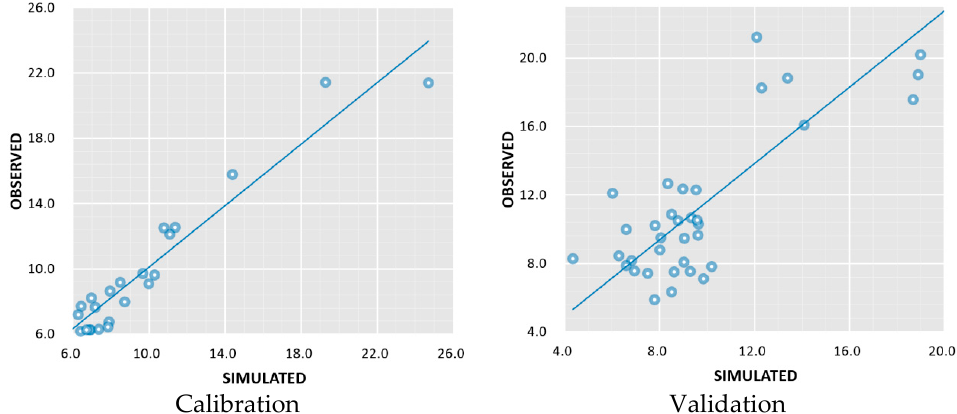
Figure 6. Deterministic coefficients of the monthly observed and simulated runoff of the Hot Spring station. Table 4. The assessment under a monthly and daily scale simulated by the CMADS+SWAT model.